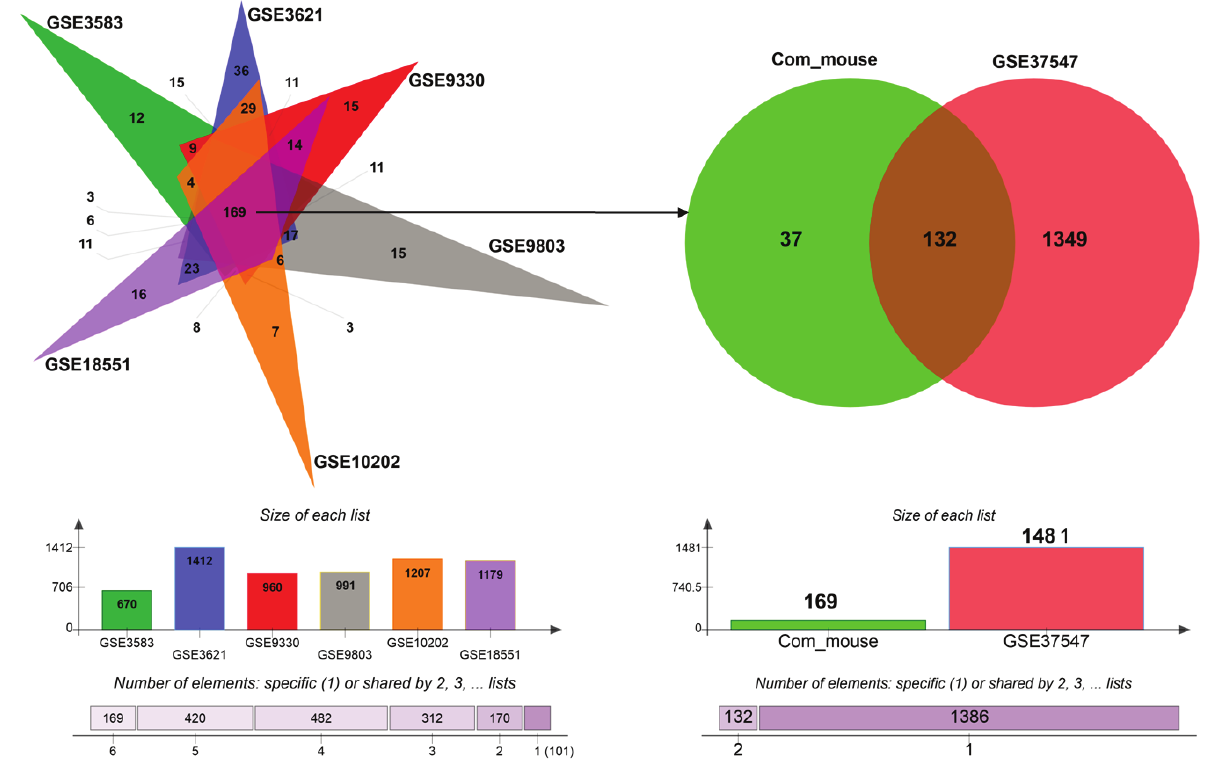
Figure 3. Up regulated UPR genes. Genes included in the core enrichment set for comparisons that indicated UPR activation (highlighted in red in Figure 2) were compared. Common upregulated UPR genes (n=169) in six HD murine models (left side) were intersected with upregulated UPR genes in human HD iPSCs (right side) resulting in a set of 132 UPR genes, whose activation was conserved across the different HD models. The bar plots (bottom) display the number of UPR genes assigned to the core enrichment sets for comparisons that indicated